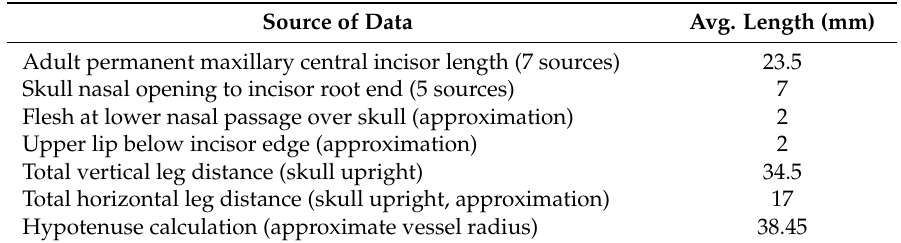
Table 8. Vessel rim radius calculation. Rim plane radius of the engineered vessel is 39